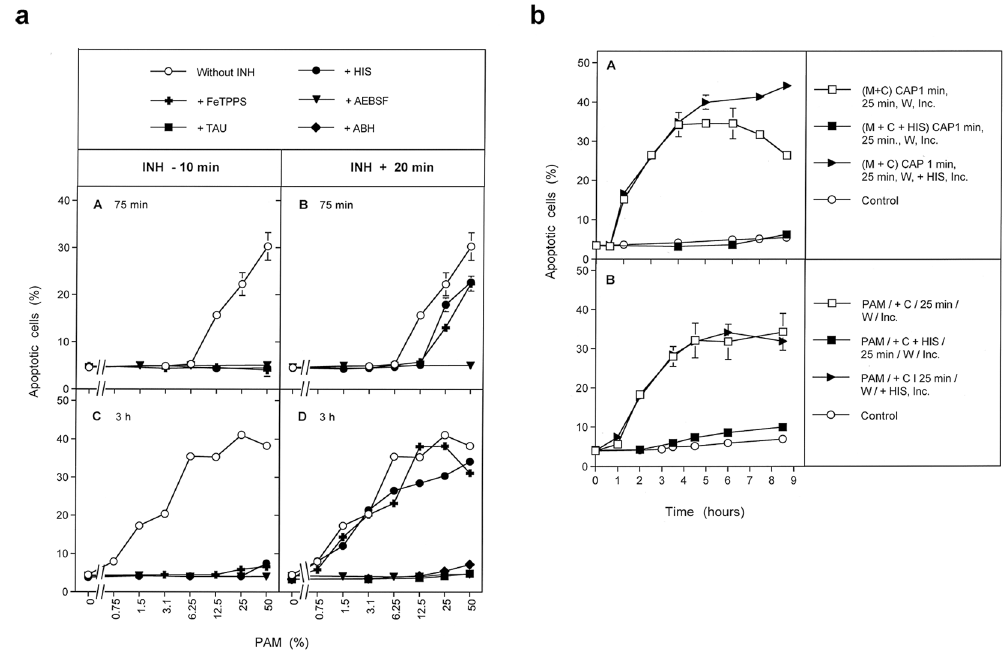
Figure 3. PAM-mediated apoptosis induction in tumor cells. ( a ) Inhibition profile of PAM-mediated apoptosis induction in tumor cells. Medium was treated with CAP for 1 min in the absence of cells for the generation of PAM. PAM was serially diluted and added at equal volumes to MKN-45 cells to reach a final volume of 100 µ l and cell density of 12 500 cells/100 µ l. The indicated inhibitors/scavengers (INH) (the 1 O 2 scavenger histidine (HIS) (2 mM), the ONOO − decomposition catalyst FeTPPS (25 µ M); the NOX1 inhibitor AEBSF (100 µ M);